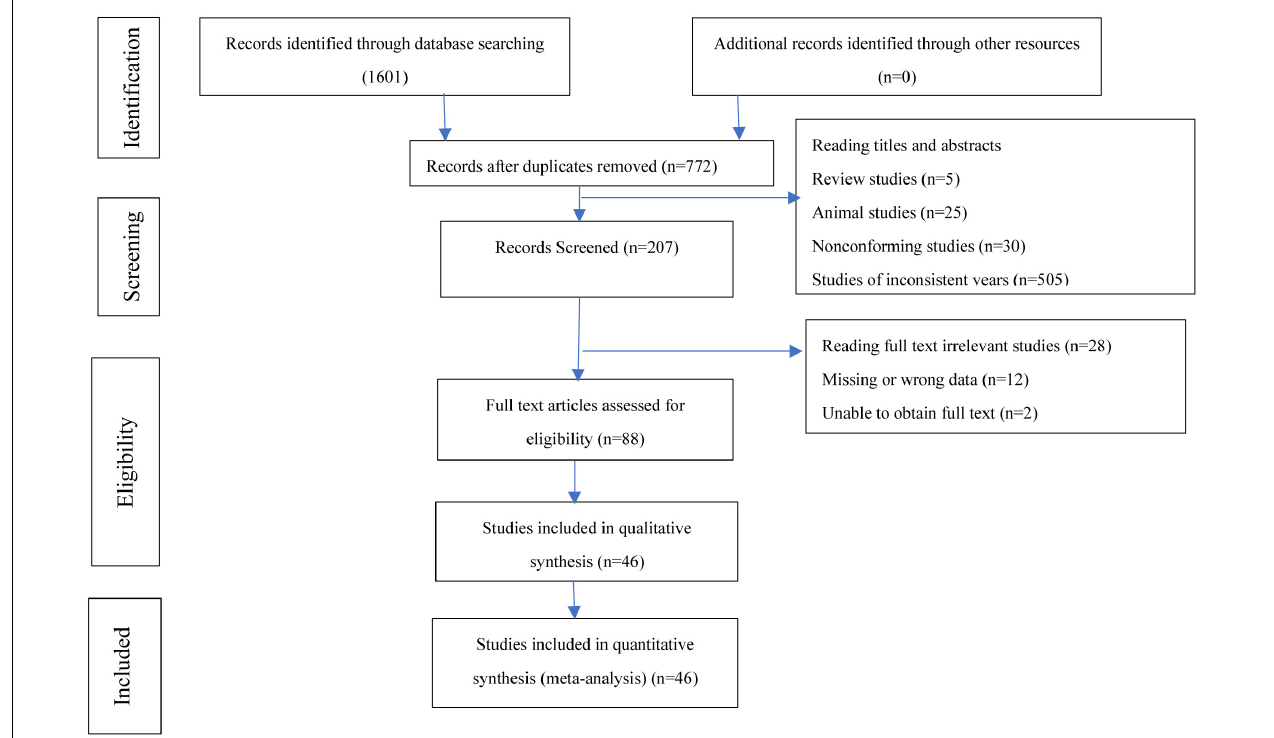
FIGURE 1 | Flow diagram of study